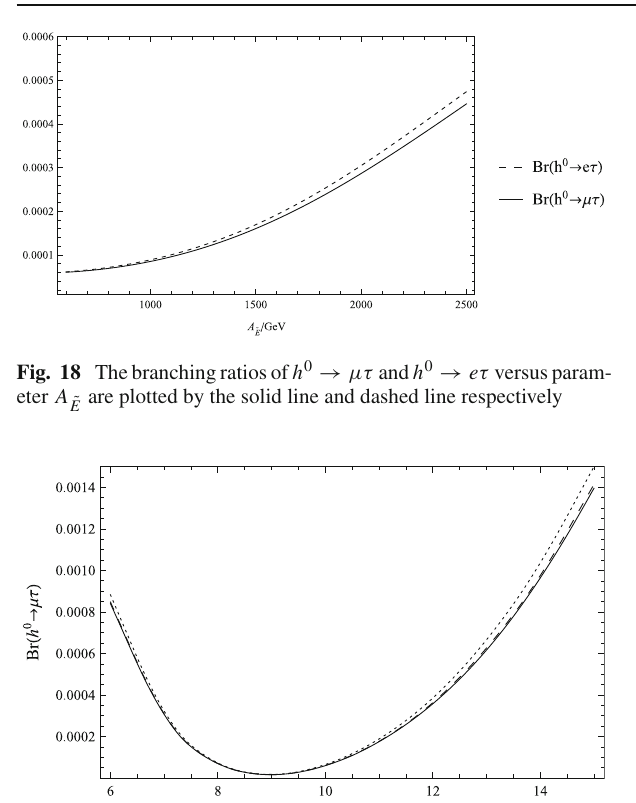
Fig. 19 With S 2 m = 1 ( 2 , 3 ) TeV 2 , the branching ratios of h 0 → μτ versus parameter tan β are plotted by the dotted, dashed and solid lines respectively